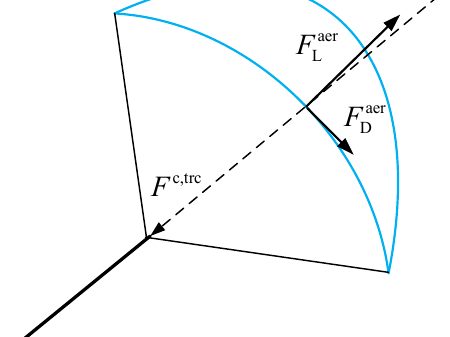
The cable traction force is shown in Figure 4: